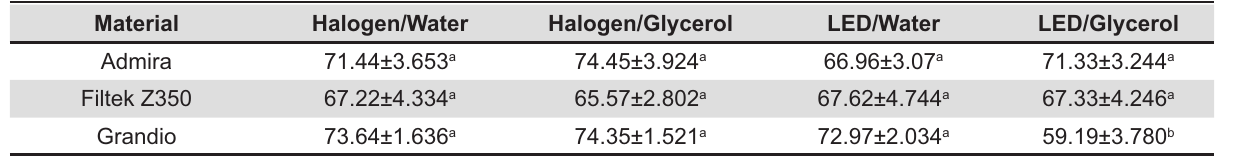
(cid:20)(cid:13)(cid:21)(cid:5)(cid:22)(cid:23)(cid:18)(cid:11)(cid:16)(cid:13)(cid:6)(cid:8)(cid:9)(cid:17)(cid:6)(cid:5)(cid:11)(cid:24)(cid:25)(cid:16)(cid:17)(cid:7)(cid:15)(cid:9)(cid:18)(cid:25)(cid:26)(cid:18)(cid:27)(cid:11)(cid:28)(cid:29)(cid:7)(cid:16)(cid:5)(cid:11)(cid:6)(cid:5)(cid:8)(cid:8)(cid:5)(cid:15)(cid:18)(cid:3)(cid:26)(cid:25)(cid:8)(cid:11)(cid:18)(cid:8)(cid:7)(cid:8)(cid:9)(cid:18)(cid:8)(cid:9)(cid:24)(cid:7)(cid:6)(cid:6)(cid:22)(cid:11)(cid:18)(cid:9)(cid:30)(cid:26)(cid:9)(cid:31)(cid:24)(cid:7)(cid:26)(cid:8)(cid:11)(cid:17)!"#"$&(cid:11) (cid:11)